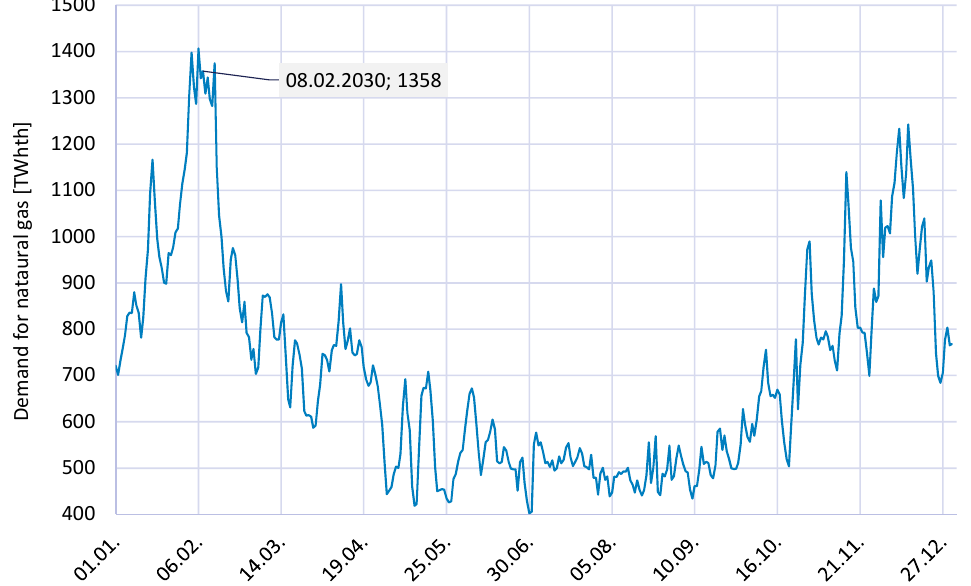
Figure 11. Results of JMM for simulated daily demand for natural gas in the German power sector in 2030.